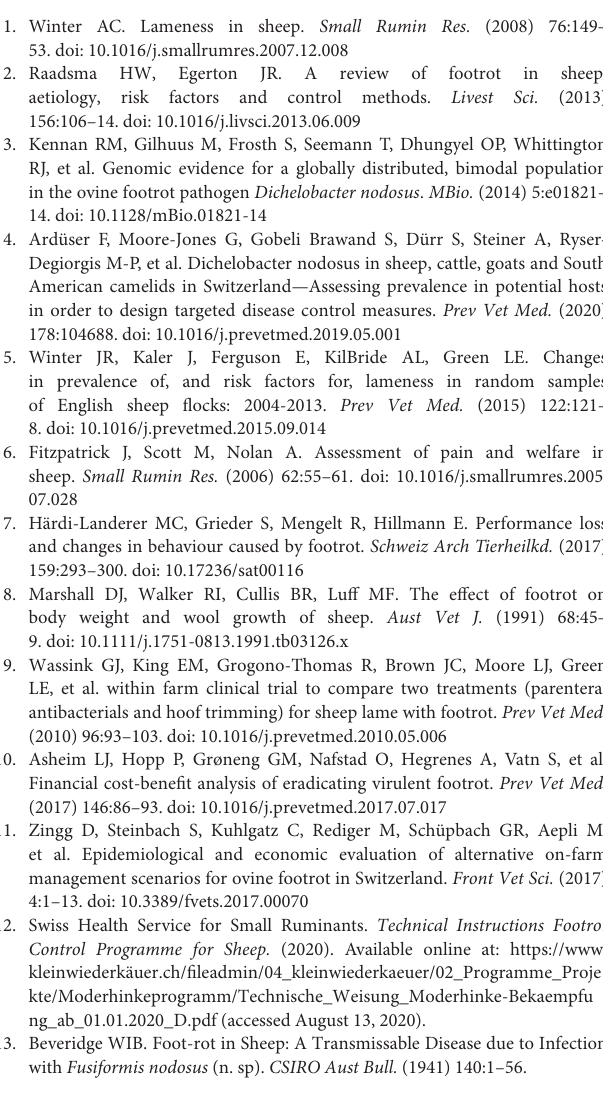
Supplementary Figure 1 | Schematic illustration of the risk-based sampling